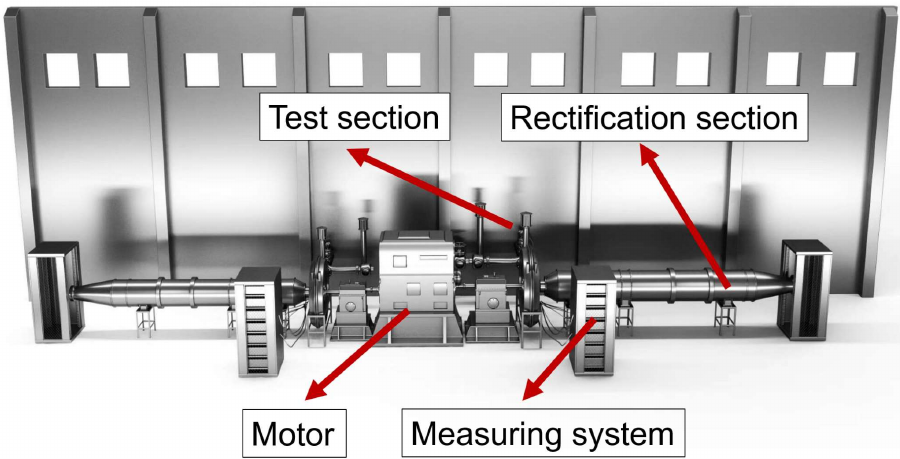
Figure 4. 3D diagram of the compressor test rig.